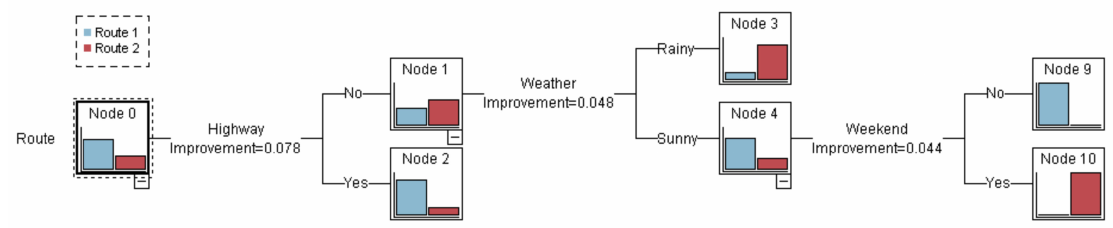
Figure 8. Decision tree